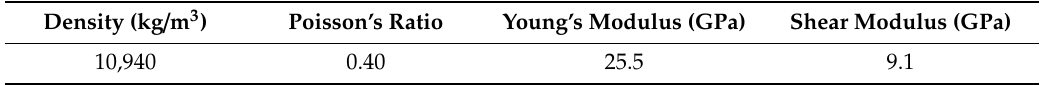
Table 1. Lead alloy core’s material parameters.